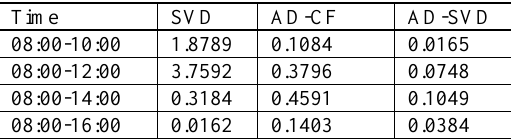
Table 2. Sub-pixel matching performance of three